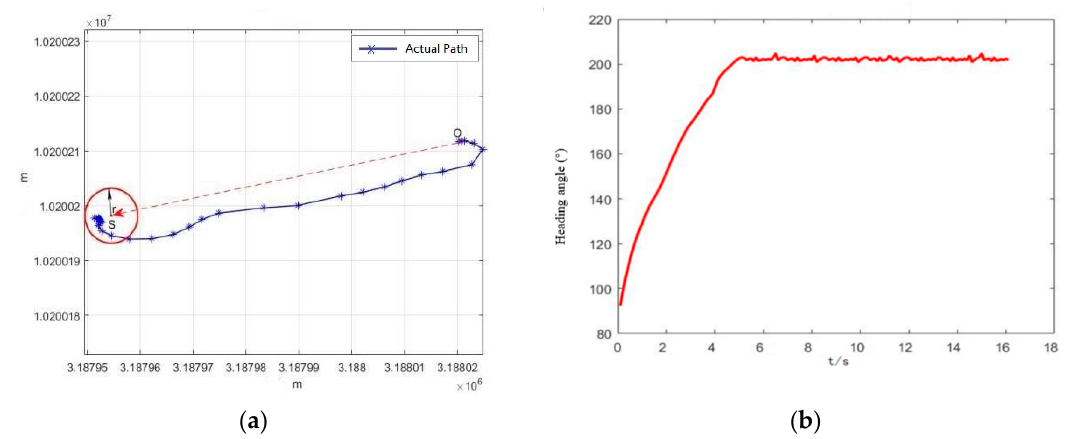
Figure 10. Result of full-scale USV test ( a : return path; b : 200° direction-preserving angle time-varying curve).